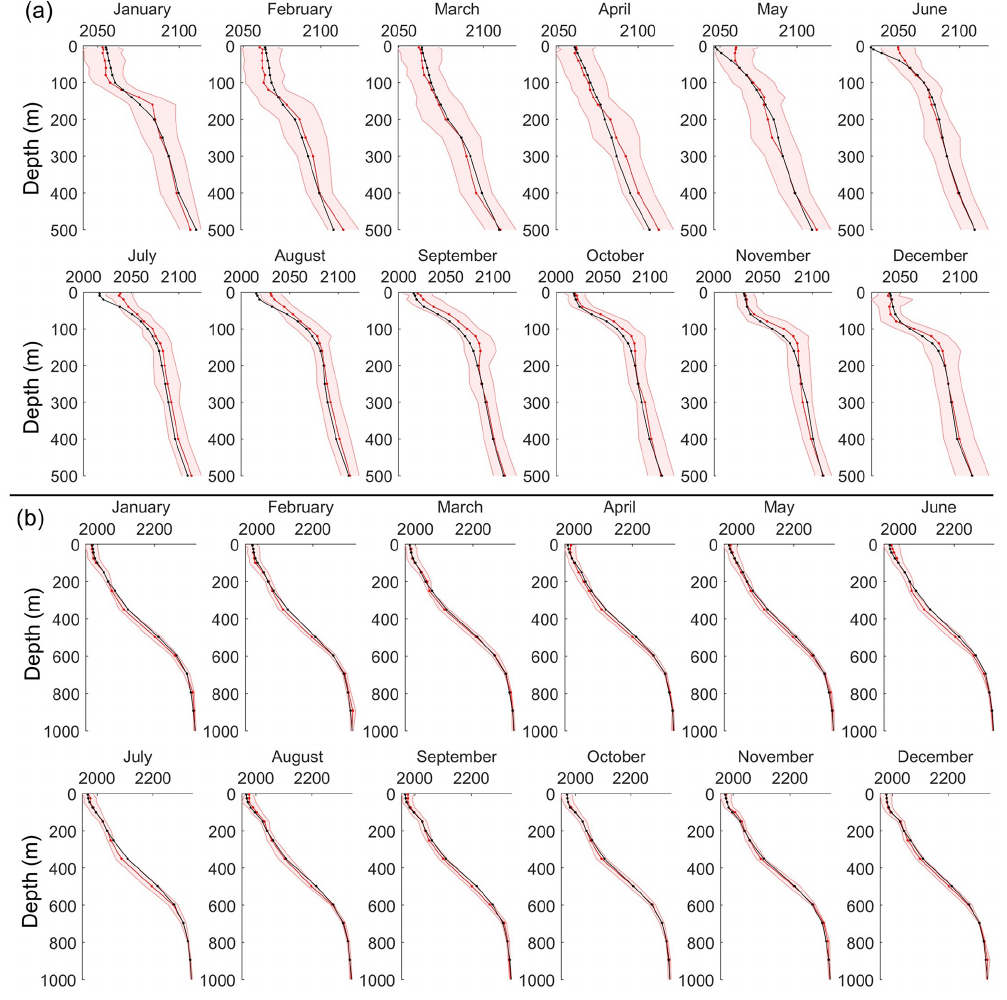
Figure 9. Comparison of the monthly climatological profiles of TCO 2 computed from measured data (red profile; shadow area is the SD of the averaged values at each depth level) and those from the TCO 2 climatology at the (a) BATS and (b) HOT ALOHA locations. The units on the x axis are micromoles per kilogram (µmolkg − 1